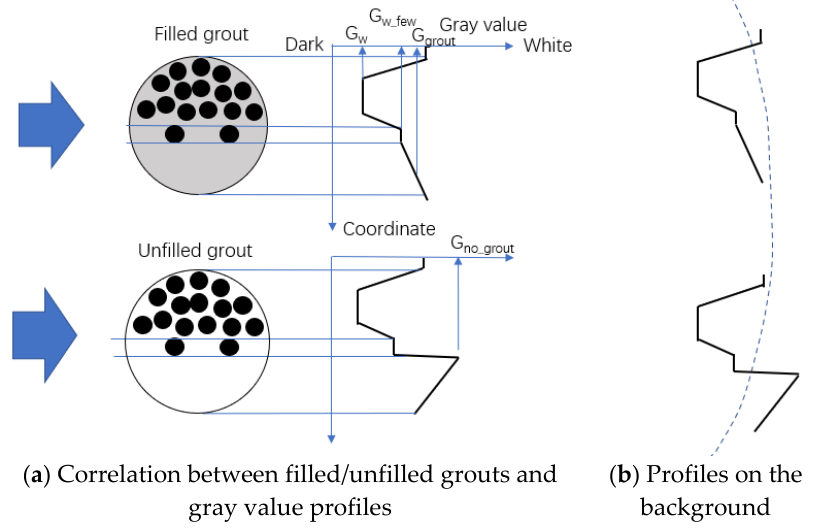
Figure 17. Schematic drawing of the correlation between filled/unfilled grouts and gray value profiles. ( a ) Typical gray value profiles for filled and unfilled grout cases; ( b ) The profiles lie on the intensity background due to point source X-rays.